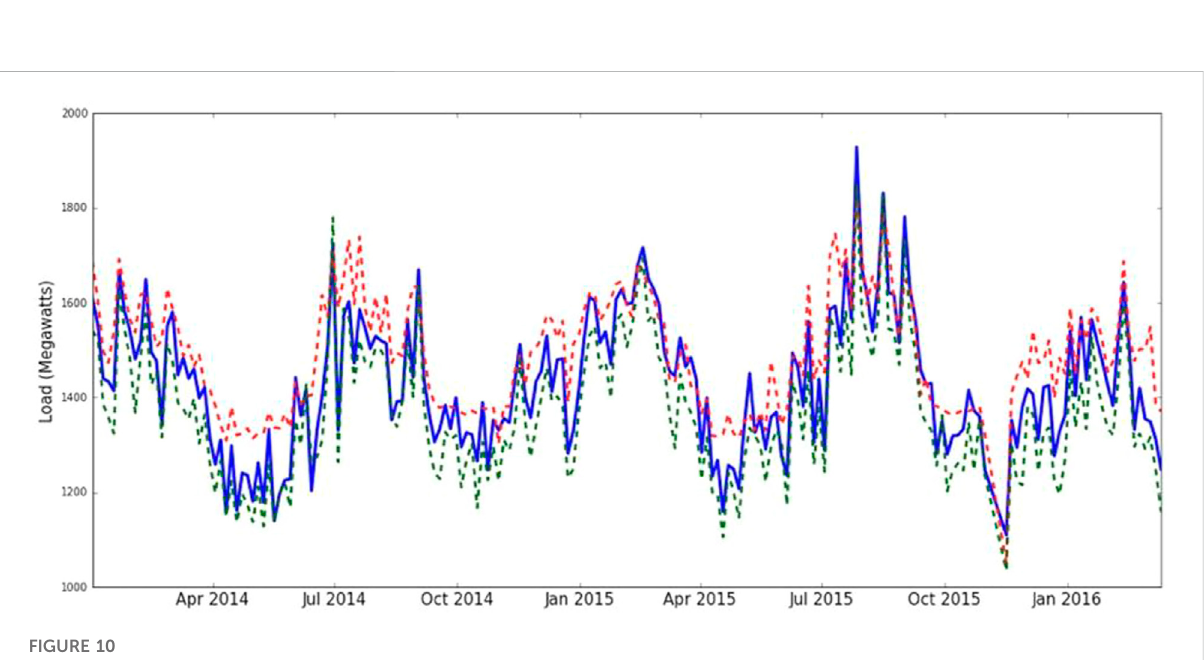
are by and largely consistent with the actual EEC curve trend. Meanwhile, our model is closer to the actual electricity consumption than the of fi cial model in terms of peak electricity consumption forecasting. And our model is more in line with the actual trend.